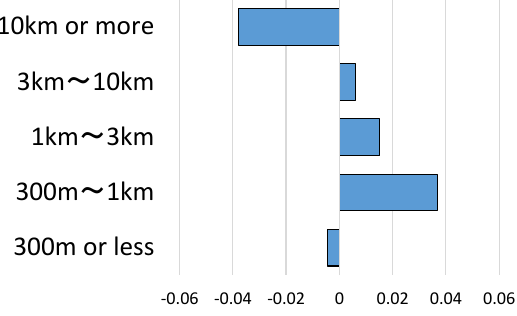
Figure 5. Distance from coastline category scores (main girders).